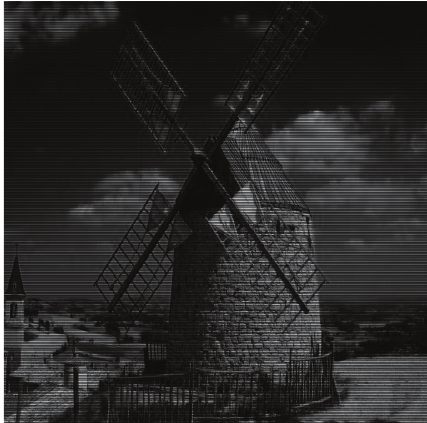
Figure 2: The reconstructed gray image of windmill. The data of the original image is encoded by the local frames of the Parseval fusion frame system computed by Example 18. The first coefficient of every local vector is deleted. The remained data is decoded by the Parseval fusion frame of Example